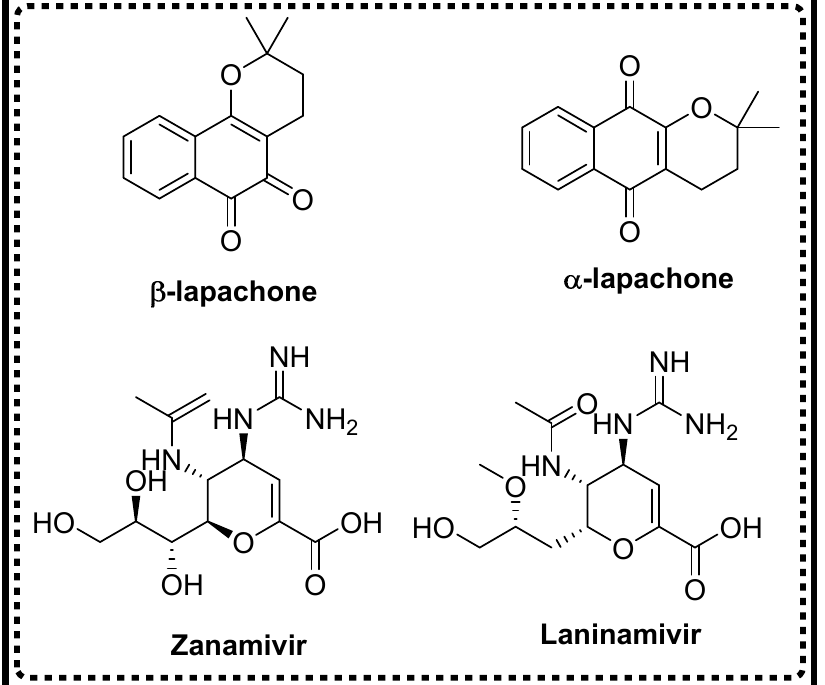
Figure 1. Commercially used pyran moiety